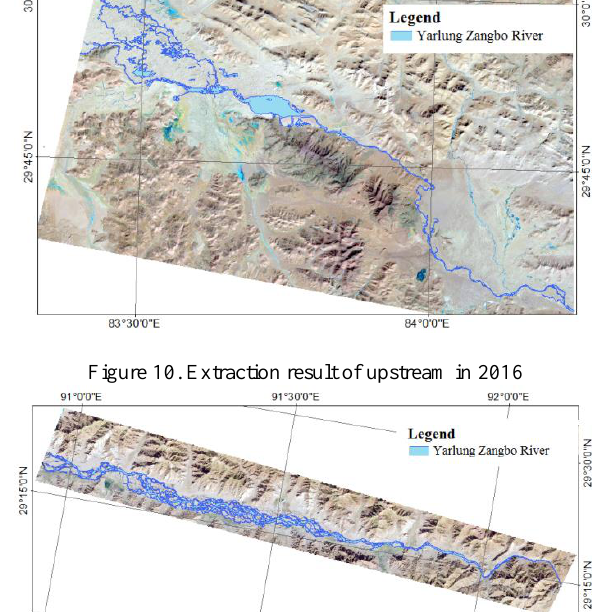
Figure 13. Superimposed river extraction results of upstream of Yarlung Zangbo River in two periods (a) Whole graph (b) Local